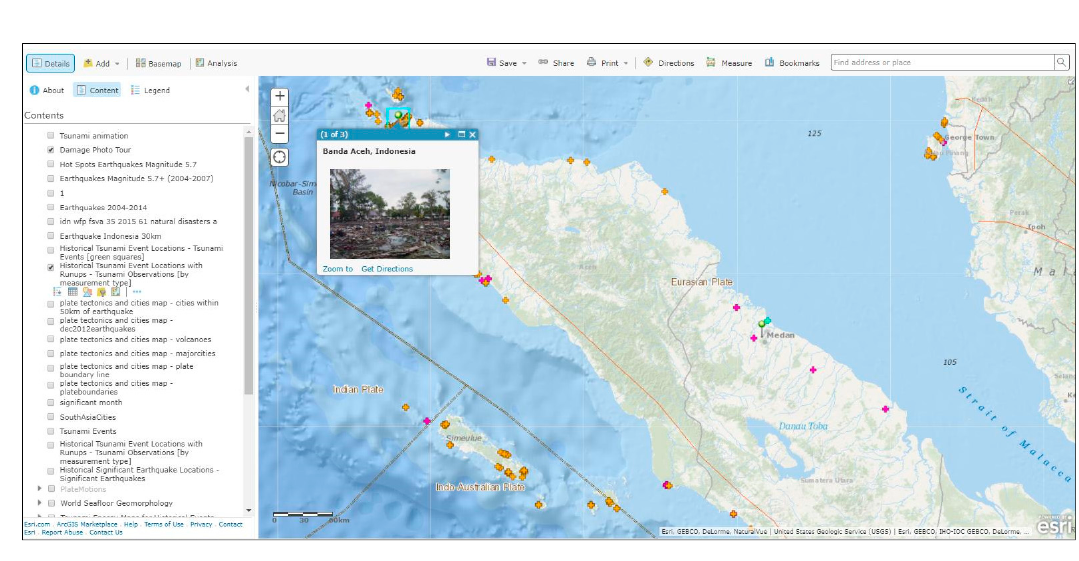
Figure 9. Aceh, Indonesia.